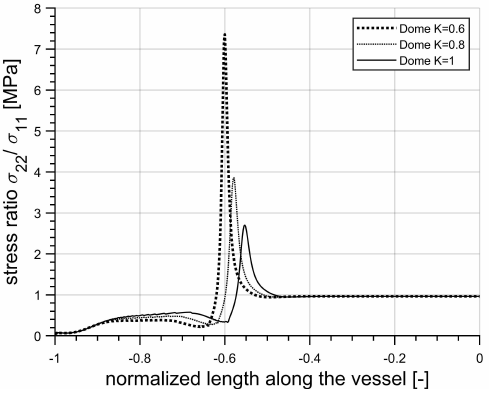
Figure 11. Ratio of fibre stresses, shown only for half length of the